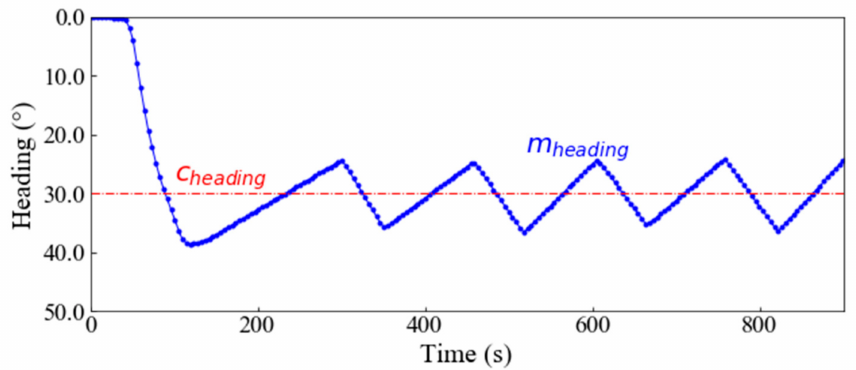
Figure 16. The heading of the glider under the control of a heading controller, which maintained the glider to a desired heading with a deadband setting of 5 ◦